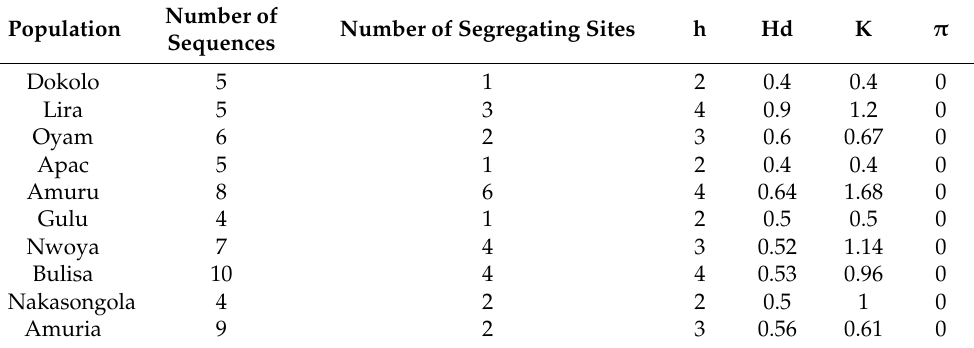
Table 6. Summary of genetic diversity indices for 658 bp fragment of the mtCOI partial gene. Number of haplotypes (h), Haplotype diversity (Hd), Average number of differences (K), and Nucleotide diversity ( π ) for each population are